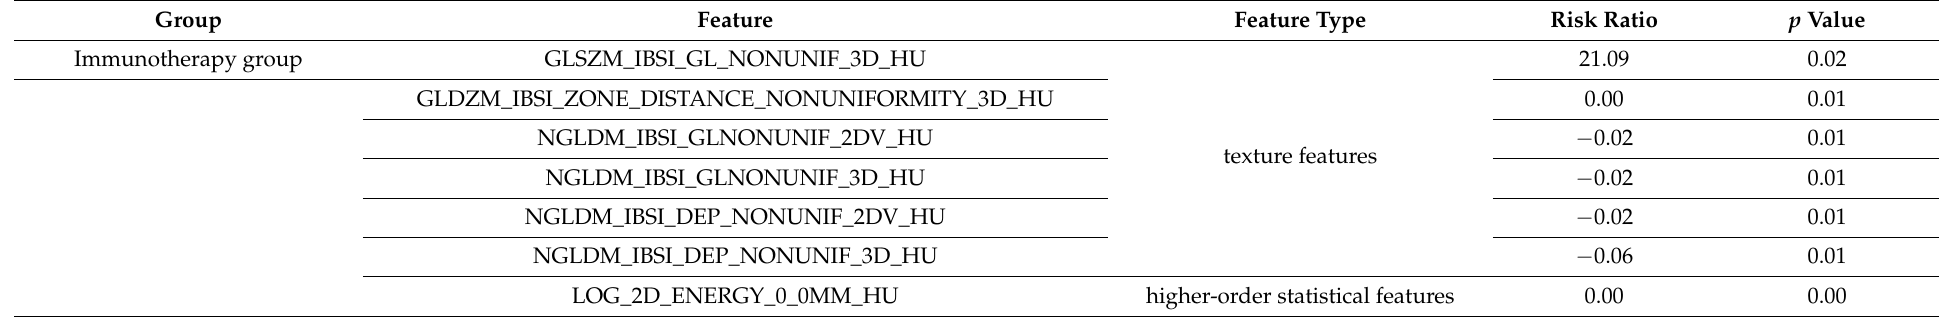
Table 2. Significant radiomic features in Cox regression analysis with risk ratio value based on OS time stratification (short and long OS time).